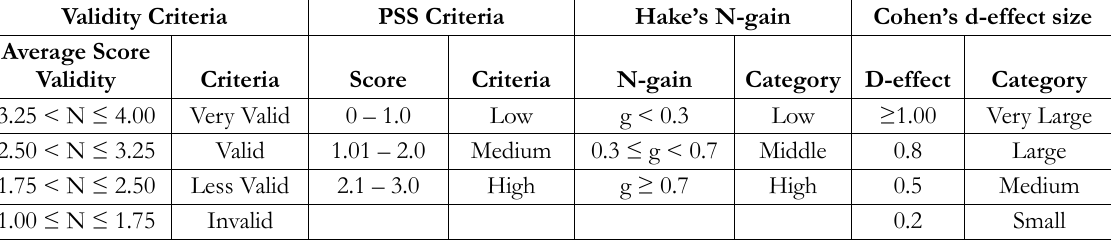
Table 3. The category of learning instrument validity criteria, PSS scoring, Hake’s N-gain, and Cohen’s d-effect